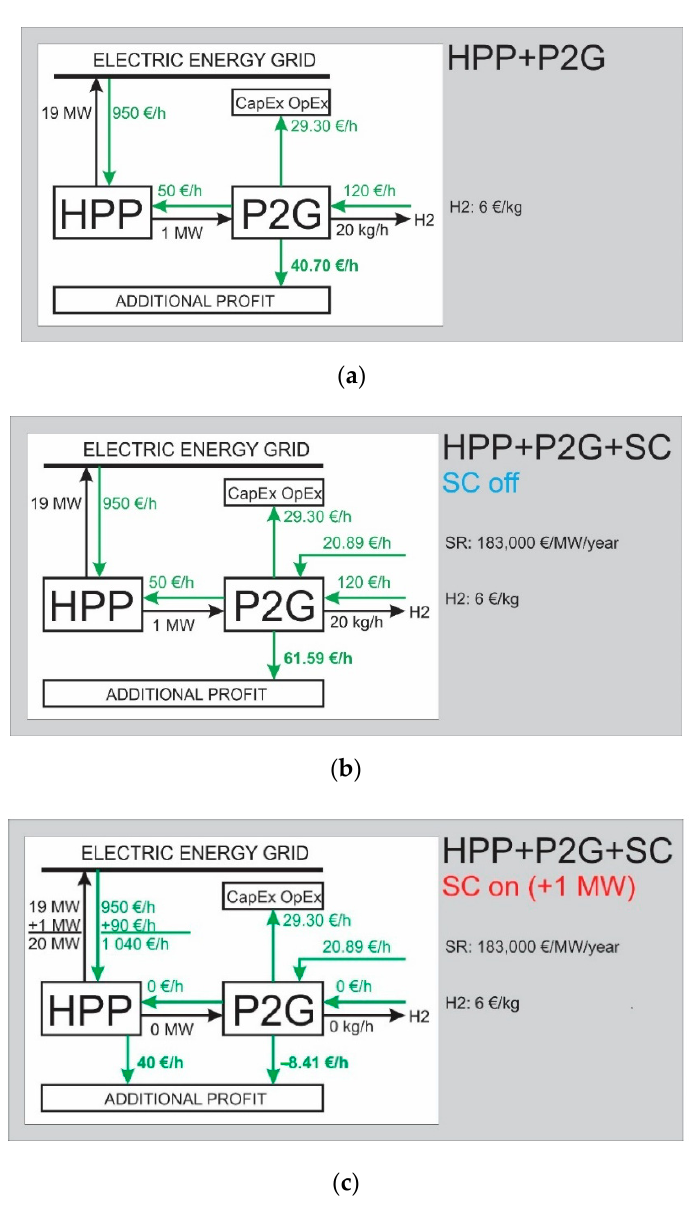
Figure 5. Financial flows for the combination of hydrogen production and SC: ( a ) HPP not involved in SC; ( b ) HPP involved in SC, SC inactive; ( c ) HPP involved in SC, SC active.